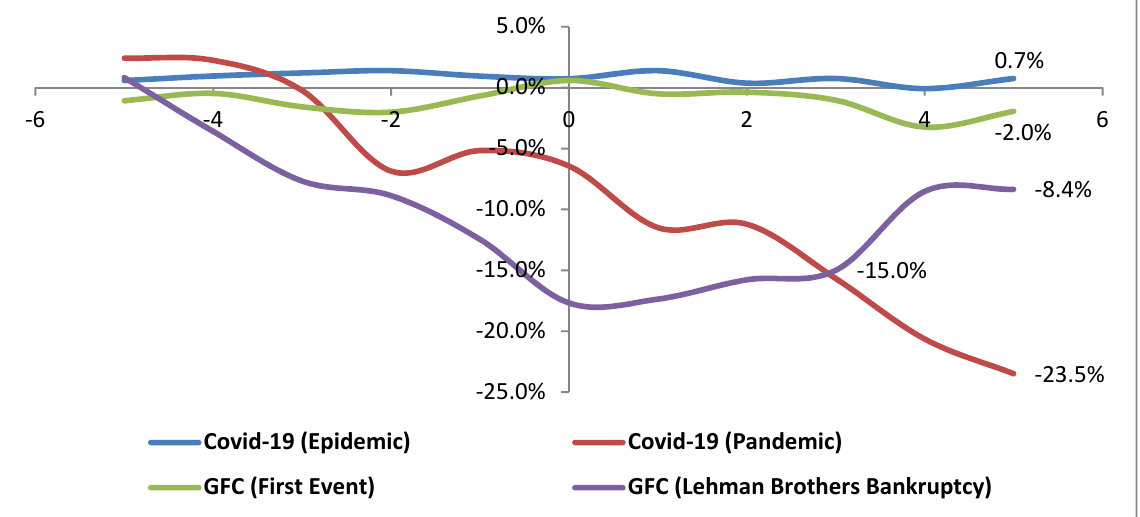
Figure 2. The JCI Cumulative Abnormal Return in the COVID ‐ 19 Outbreak and Global Financial Crisis. Figure 3 illustrates the cumulative abnormal return of JCI during the four ‐ event